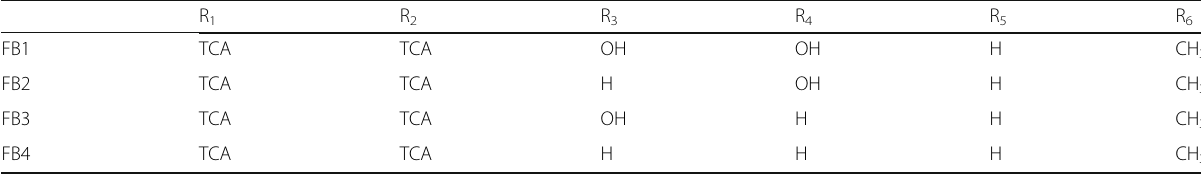
Table 3 Representation of different groups contained in fumonisins